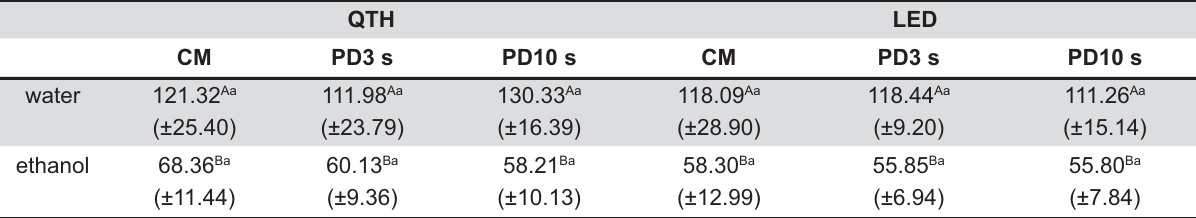
Values with same superscript capital letter (A, B or C) denote no statistical differences (p>0.05) Table 4- (cid:2)(cid:3)(cid:4)(cid:5)(cid:6)(cid:7)(cid:8)(cid:2)(cid:7)(cid:9)(cid:5)(cid:6)(cid:10)(cid:5)(cid:11)(cid:10)(cid:2)(cid:10)(cid:4)(cid:12)(cid:13)(cid:5)(cid:9)(cid:13)(cid:14)(cid:6)(cid:7)(cid:2)(cid:15)(cid:16)(cid:17)(cid:18)(cid:19)(cid:2)(cid:20)(cid:14)(cid:11)(cid:2)(cid:21)(cid:13)(cid:5)(cid:22)(cid:13)(cid:5)(cid:23)(cid:2)(cid:24)(cid:4)(cid:22)(cid:25)(cid:11)(cid:5)(cid:23)(cid:2)(cid:7)(cid:9)(cid:11)(cid:4)(cid:6)(cid:26)(cid:9)(cid:27)(cid:2)(cid:5)(cid:9)(cid:2)#$(cid:2)(cid:30)(cid:31)!" 2